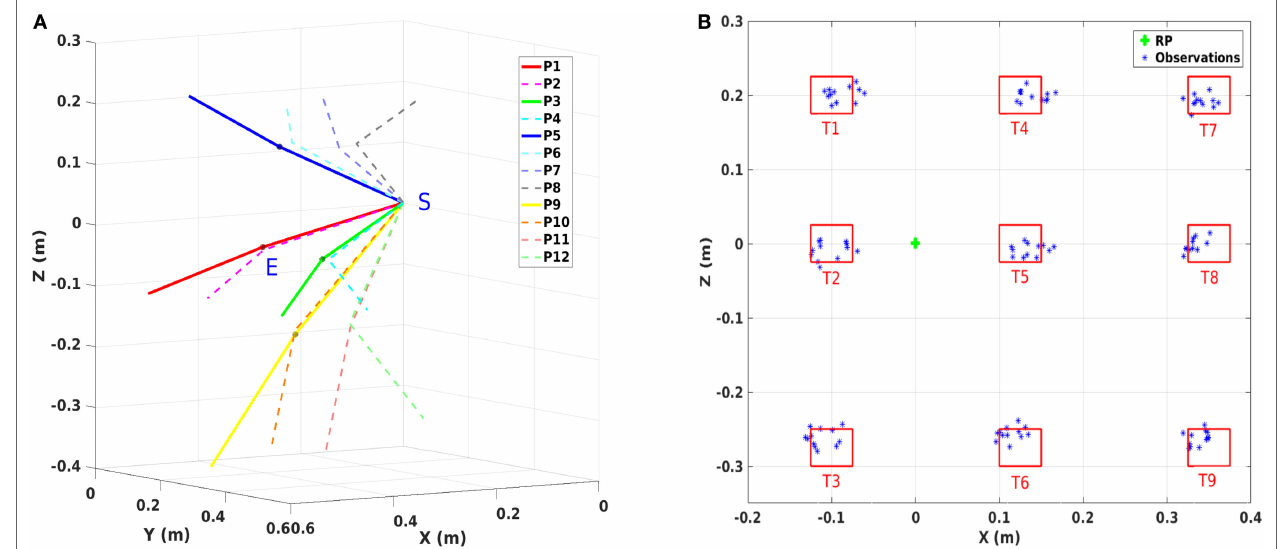
FIGURE 5 | Experimental setup. (A) Visualization of 12 starting joint angle configurations. P1 to P4 are the postures with q 1 in the middle (no rotation), while P5 to P8 are the postures with q 1 in the up region and P9 to P12 with q 1 in the down region. (B) Target areas on the board surface. RP denotes the reference point. Observations are the actual positions where the 108 averaged trajectories terminate on the board surface.